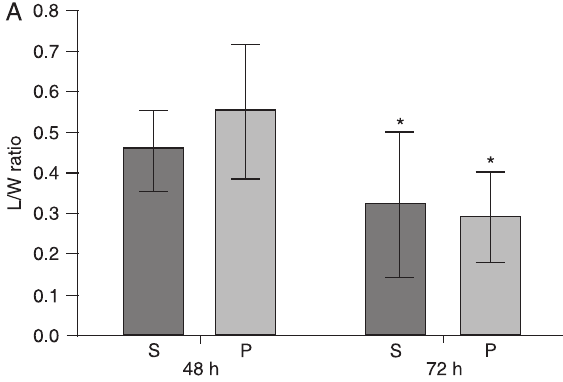
Figure 5. Lumen/wall ratio (L/W ratio) graph showing decreased values at 72 h. Lower values of this index indicate vasoconstric- tion. Data are reported as mean ± CI95%. S = sham-operated; P = pneumonectomy. *P < 0.05 compared to rats sacrificed after 48 h (two-way ANOVA). No difference was observed between pneumonectomy and control